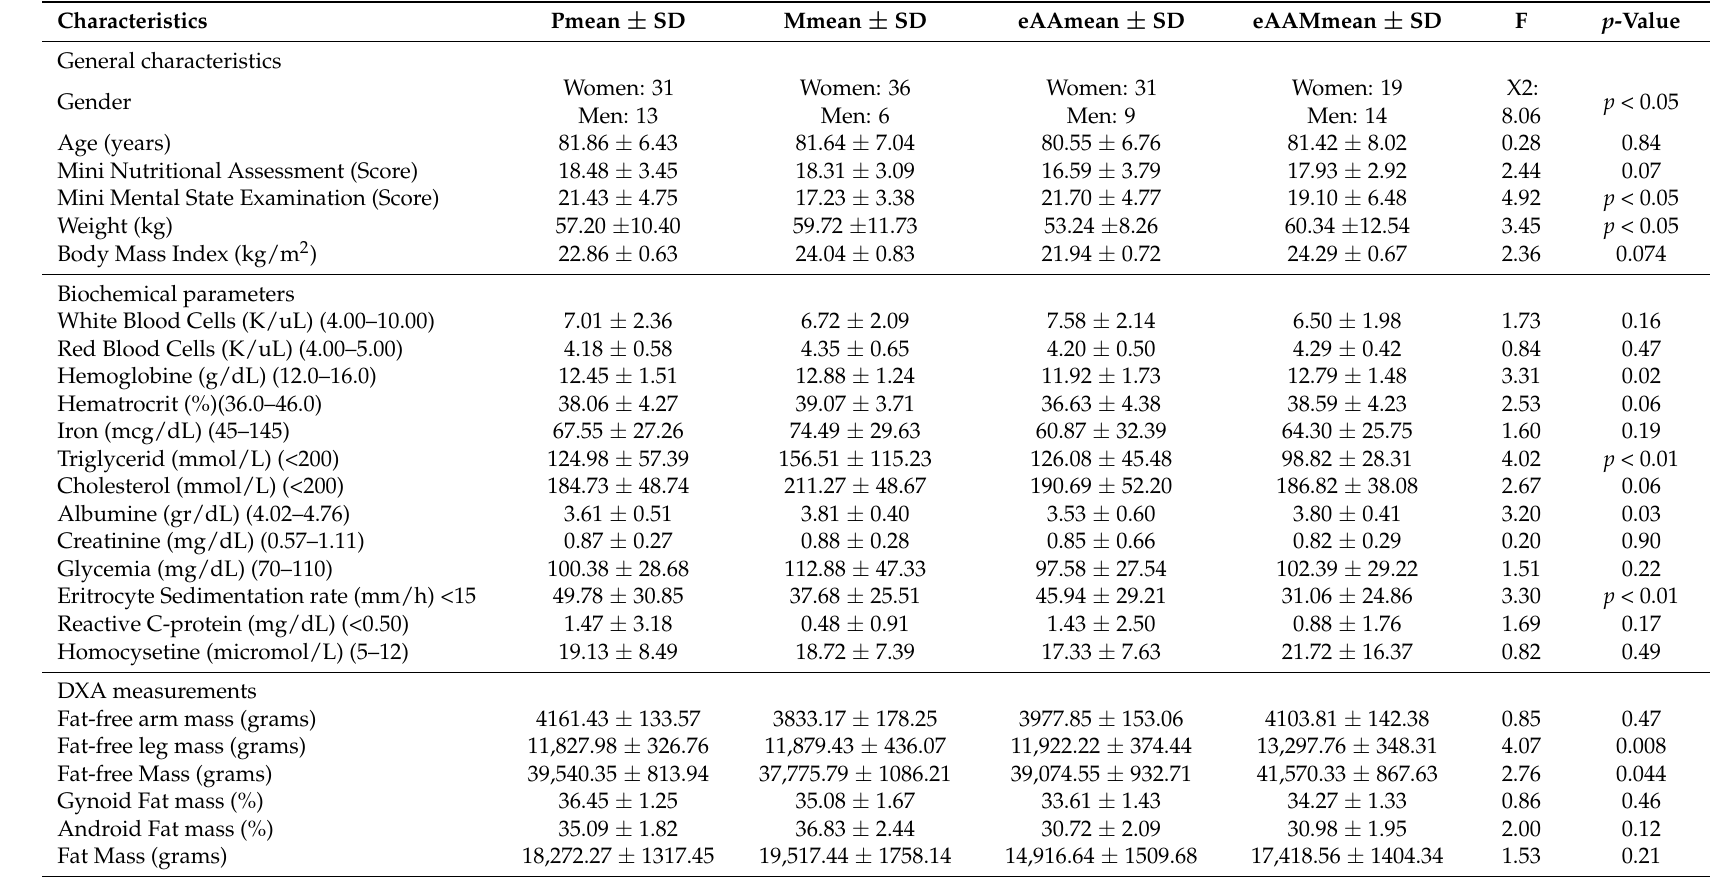
Table 1. Characteristics of participants at baseline according to study